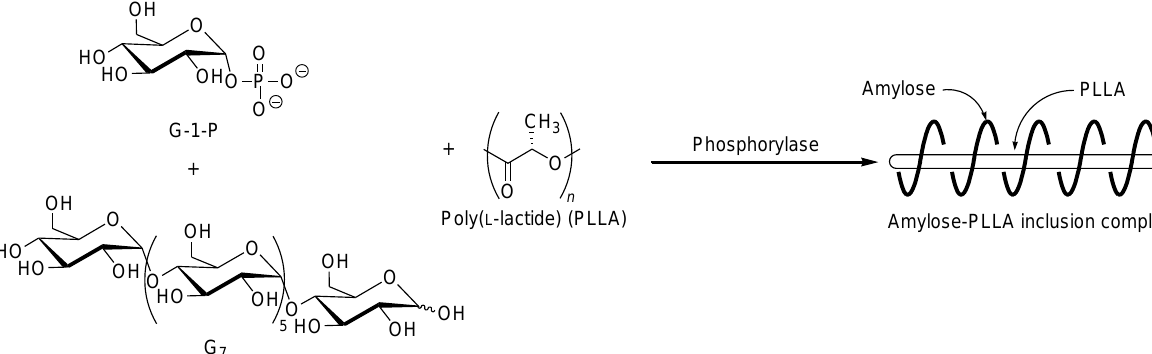
Figure 11. Stereoselective inclusion complexation by amylose in vine-twining polymerization using poly( L -lactide)